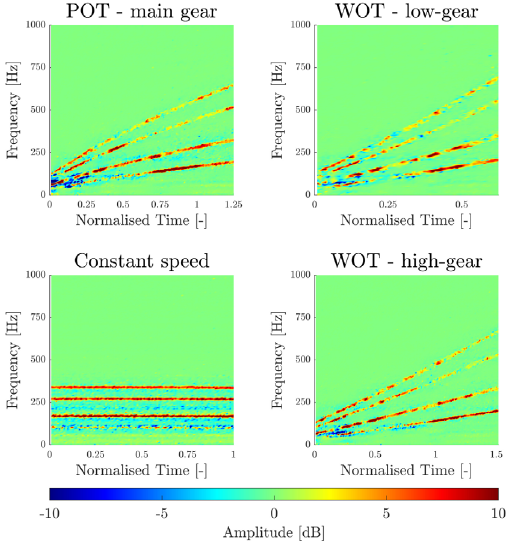
Figure 13. Spectrogram of the attenuation averaged over the 4 error microphones during the POT in the main